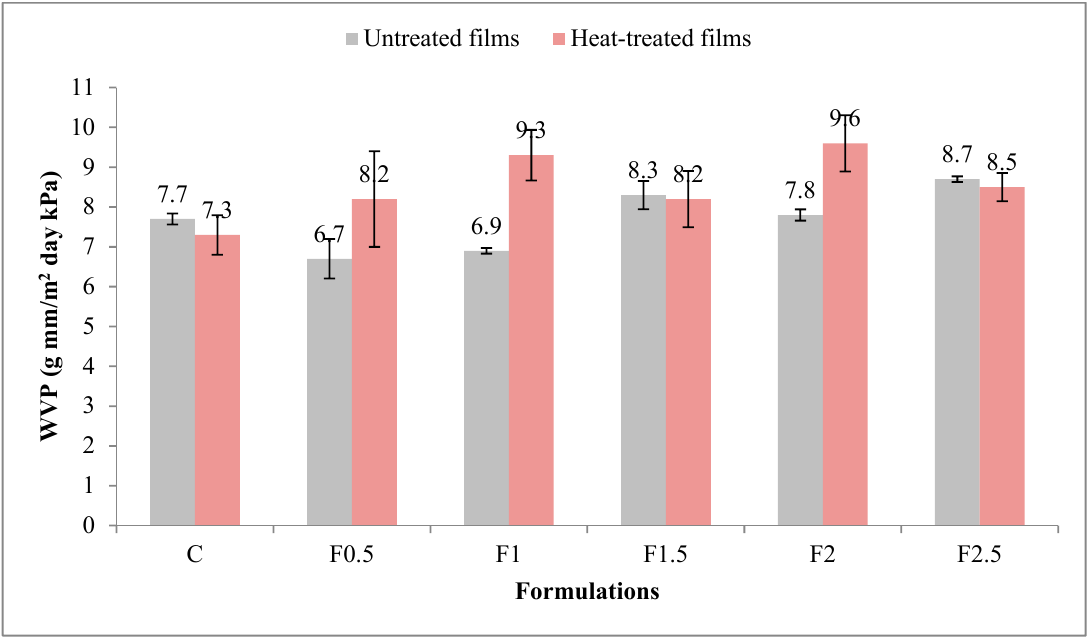
Figure 6. Variation in water vapor permeability (WVP) with heat treatment and formulation. C-control film; F0.5-film with 0.5% tarragon essential oil; F1-film with 1% tarragon essential oil; F1.5-film with 1.5% tarragon essential oil; F2-film with 2% tarragon essential oil; F2.5-film with 2.5% tarragon essential oil. Values are expressed as mean ± standard deviation of three replicates.